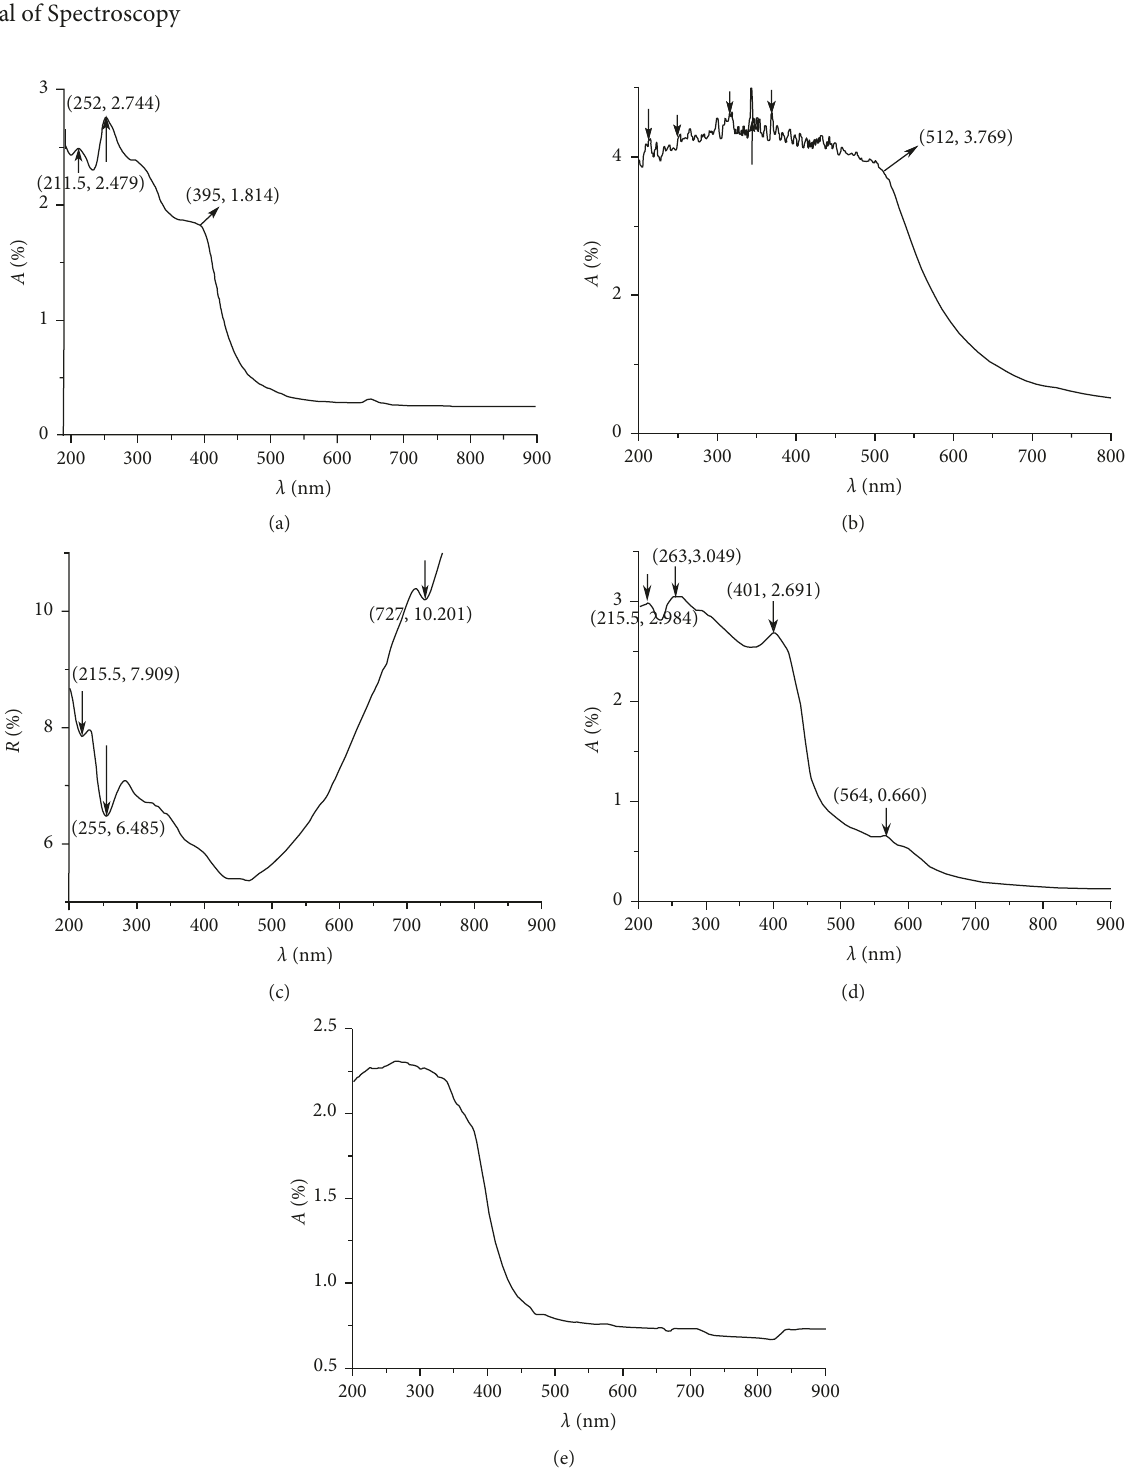
Figure 4: UV-Vis spectra of amber, copal, and rosin samples. Burmese amber samples: (a) A-1, (b) A-2, and (c) A-3. (d) Copal sample (KB). (e) Rosin sample